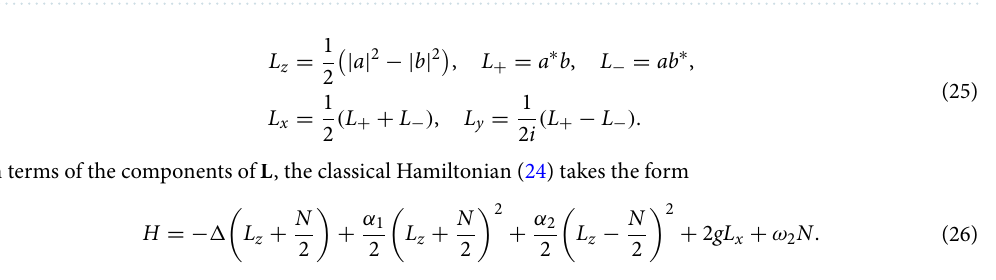
1.816 (right). This ≈